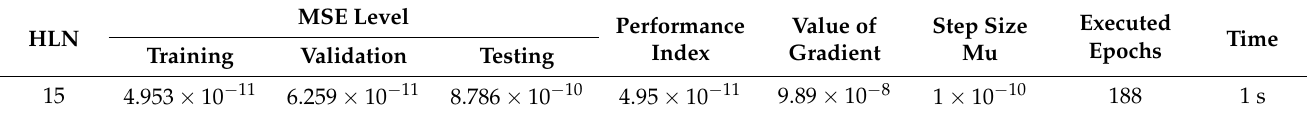
Table 3. ANNLMB outcomes of Scenario 1 for heat transfer in spinning nanofluid.